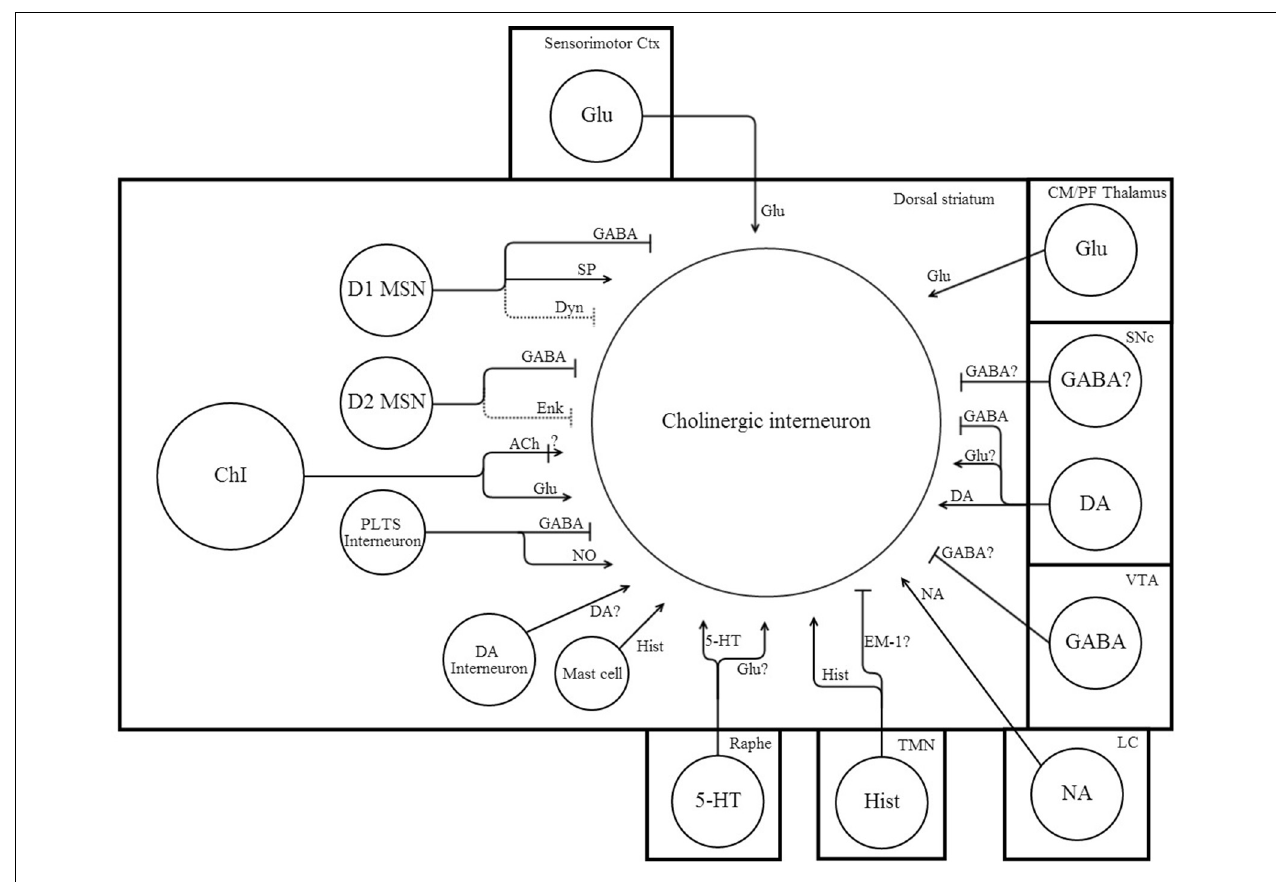
FIGURE 1 | Network connectivity of dorsal striatal cholinergic interneurons. Simplified schematic illustrating some of the afferent synaptic inputs onto ChIs. Arrow heads indicate excitation, while perpendicular lines indicate inhibition. Dotted lines indicate a weak